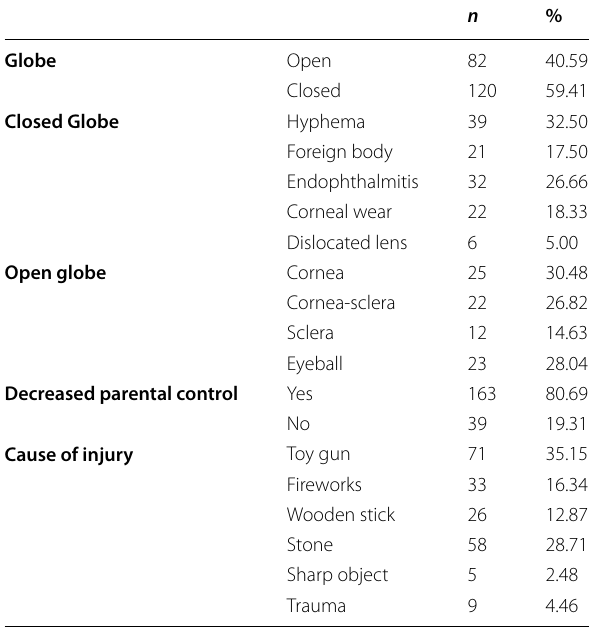
Table 2 Ocular traumas and injury characteristics